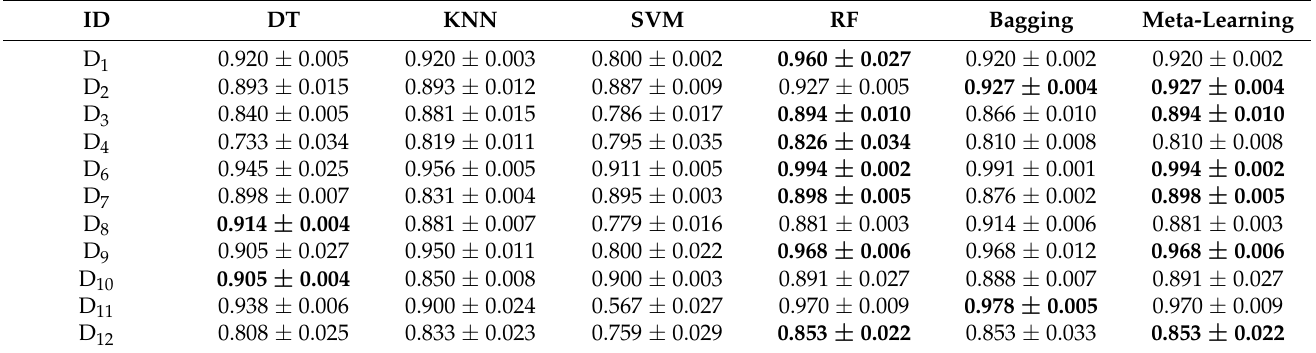
Table 4. Accuracy comparison between meta-learning and traditional ML algorithms in quinaries.